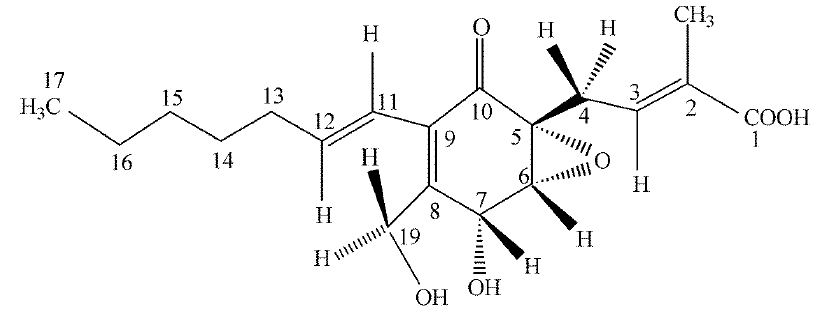
Figure 5. The structure of ambuic acid.